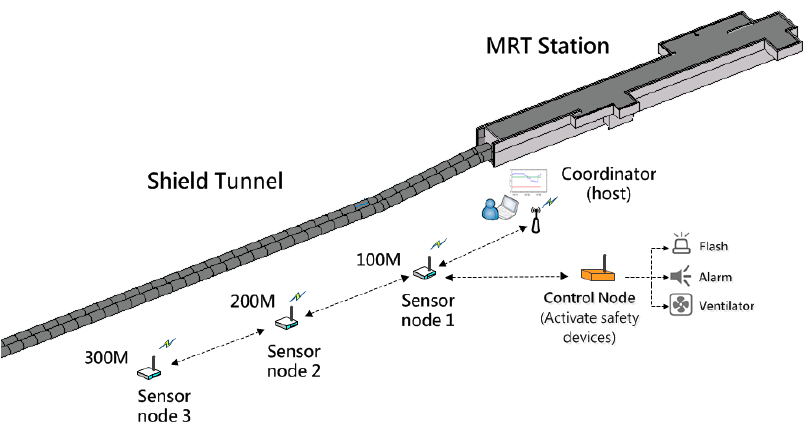
Figure 15. The layout of the WSN experiment in tunnel. Figure 15 . The layout of the WSN experiment in tunnel.